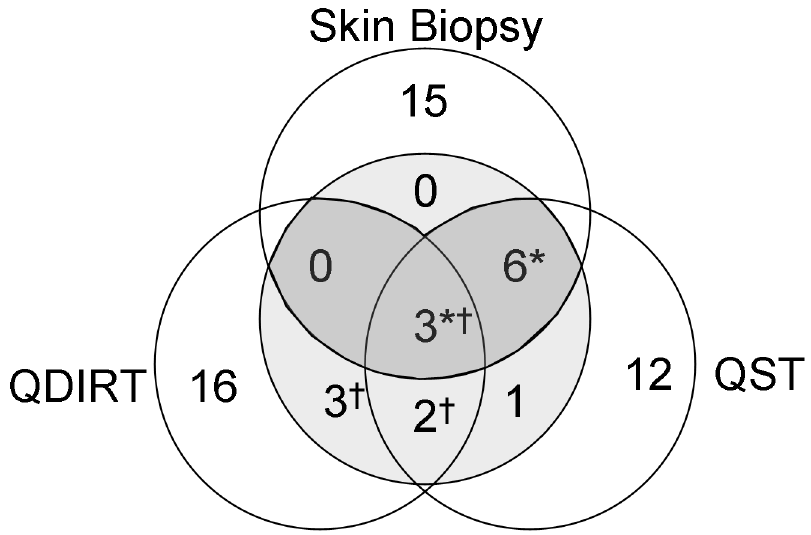
Figure 1. Distribution of test results. Abnormal results are displayed within the lightly shaded region. The 9 individuals that meet criteria for neuropathic POTS (abnormal skin biopsy and 1 other abnormal test) are in the darkly shaded region. A total of 9 subjects had abnormal intra-epidermal nerve fiber density (skin biopsy). A total of 12 individuals had abnormal quantitative sensory testing (QST). A total of 8 individuals had abnormal sudomotor (QDIRT) testing. * = individuals with neuropathic POTS, † = individuals with cholinergic